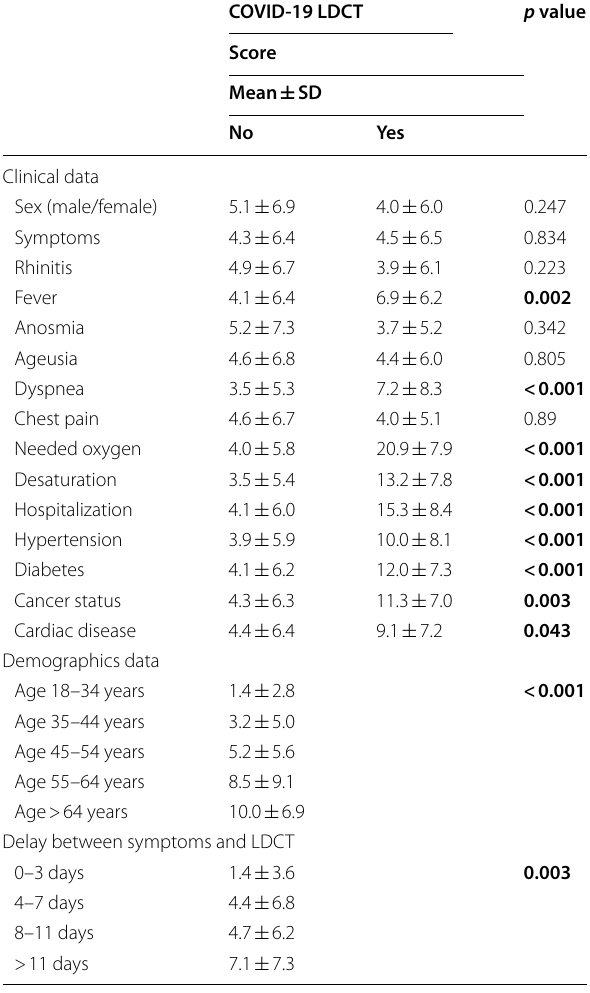
Table 2 CT-SS according to clinical data ( n